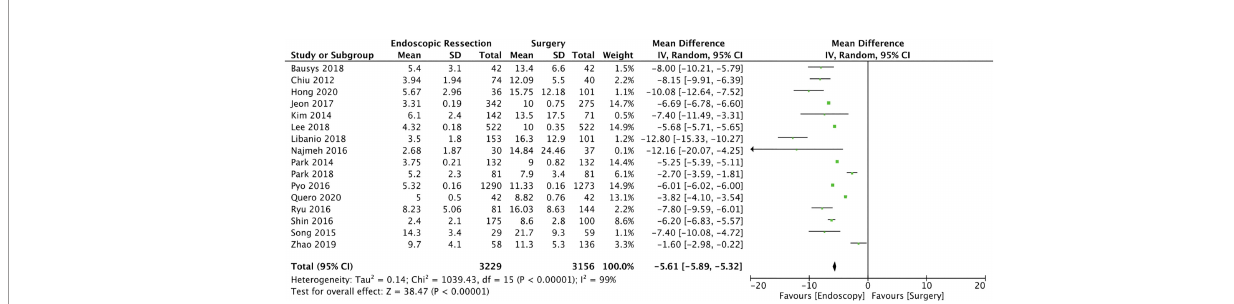
FIGURE 3 | Forest Plot Length of Hospital Stay.